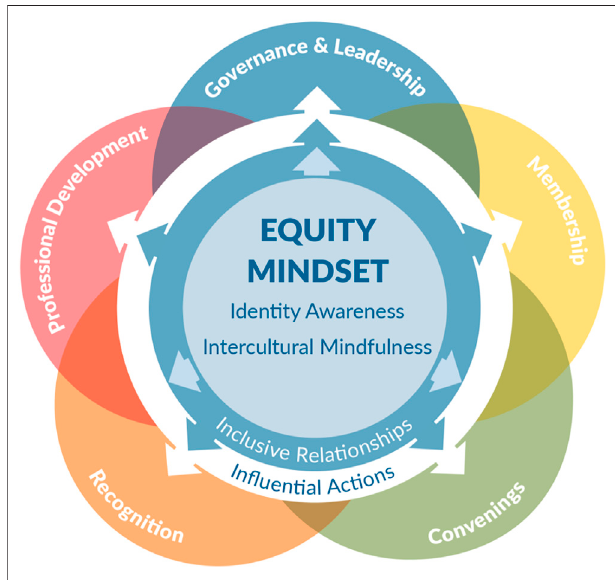
FIGURE 1 | The IPF: Societies graphic with fi ve example professional society functions (INCLUDES Aspire Alliance National Change, n.d.).